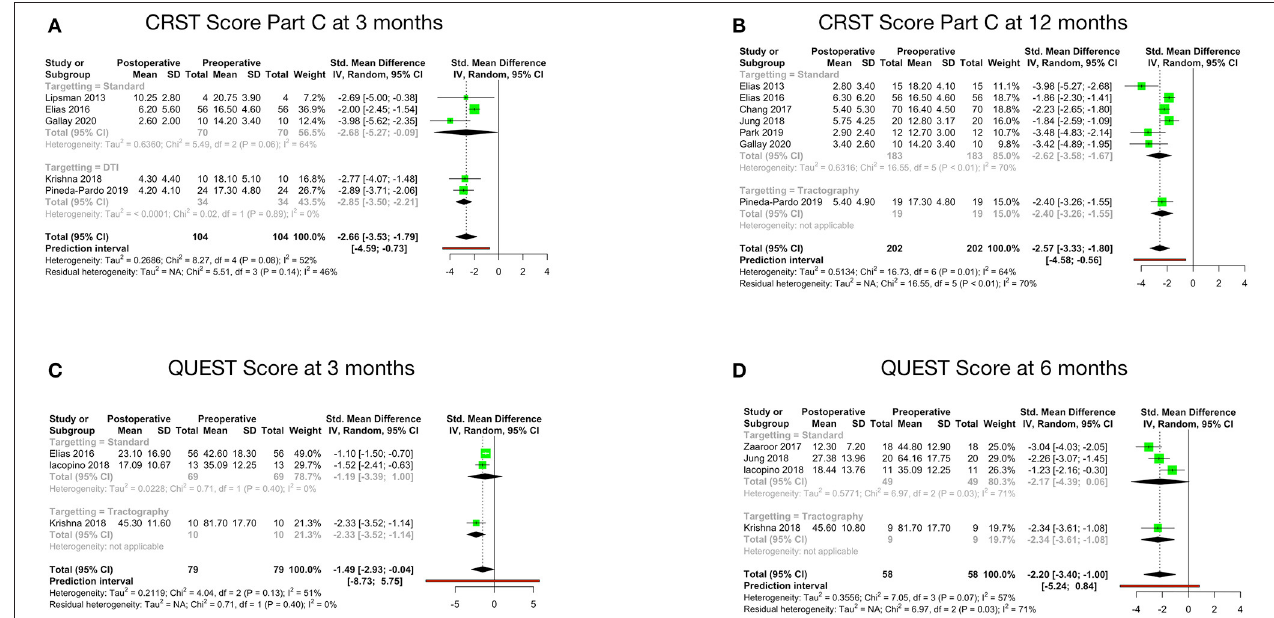
FIGURE 3 | Pooled standard mean difference between preoperative and postoperative disability scores at 3 months (A) , disability scores at 12 months (B) , QUEST scores at 3 months (C) and QUEST scores at 6 months (D) .